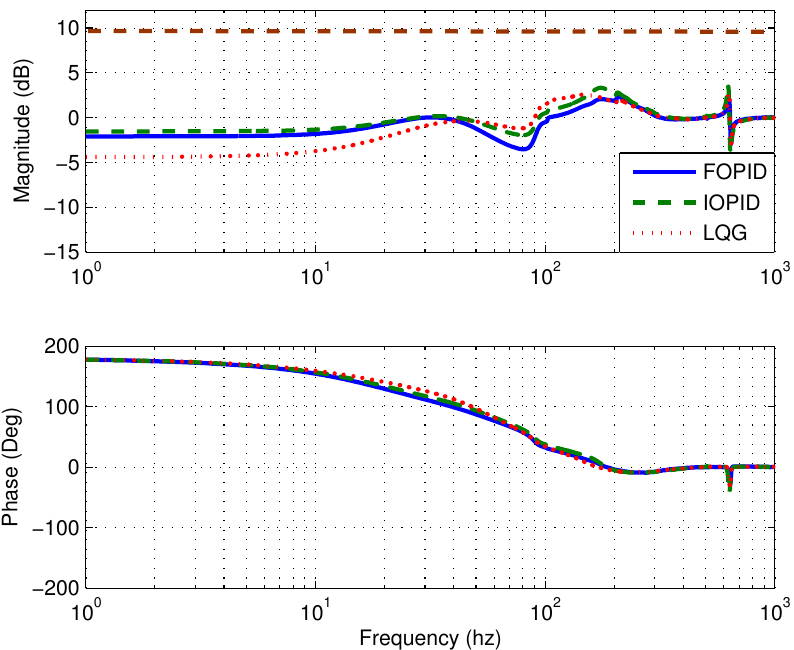
Figure 26. Bode plots of the lateral AMB sensitivity function at the compressor